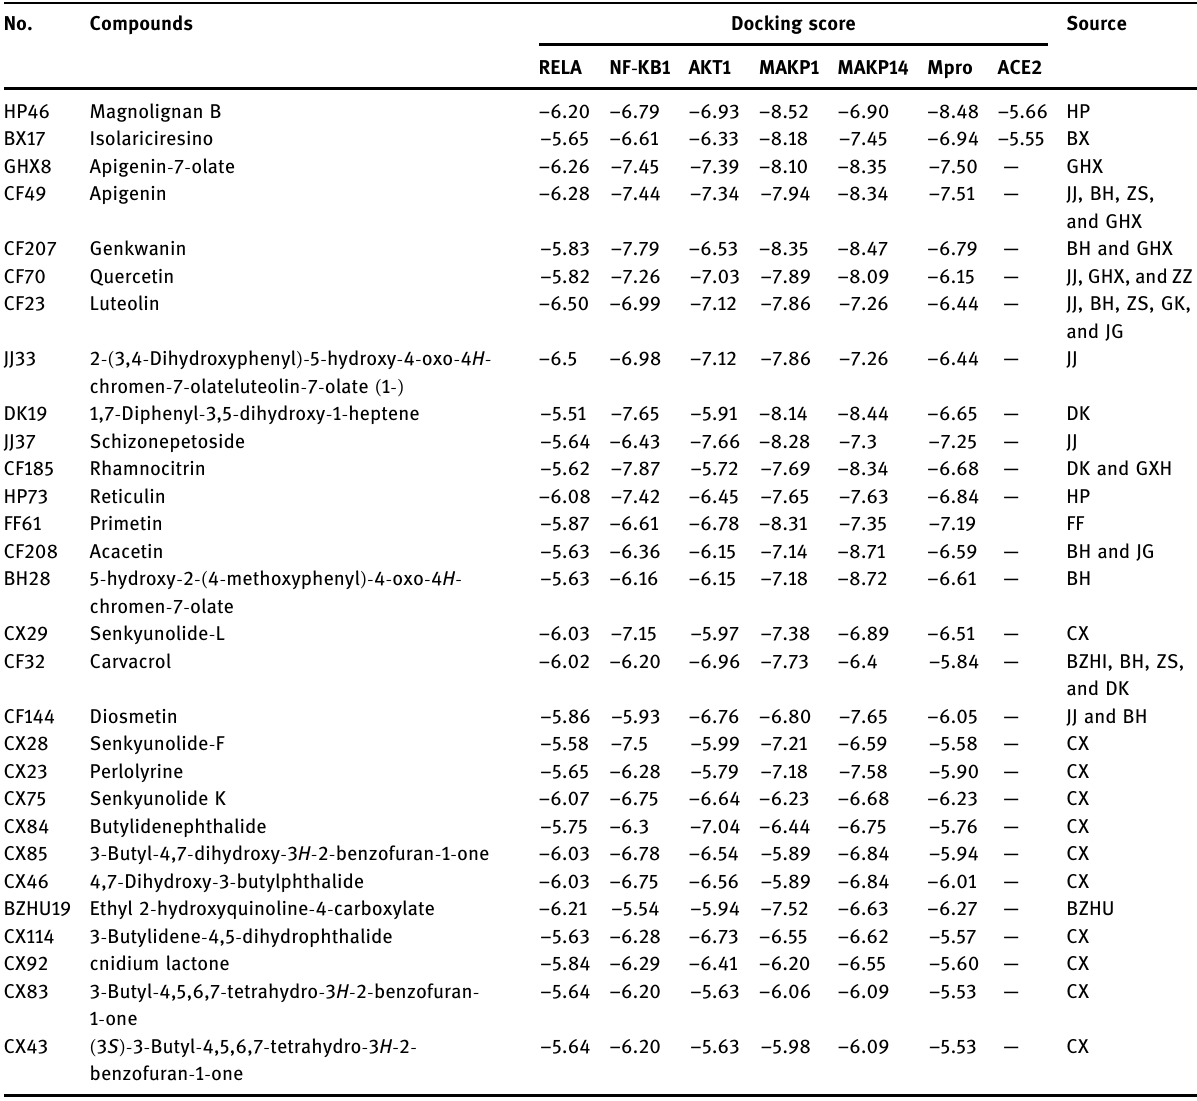
Table 2: Molecular docking results ( docking score greater than 5.5 kcal/mol